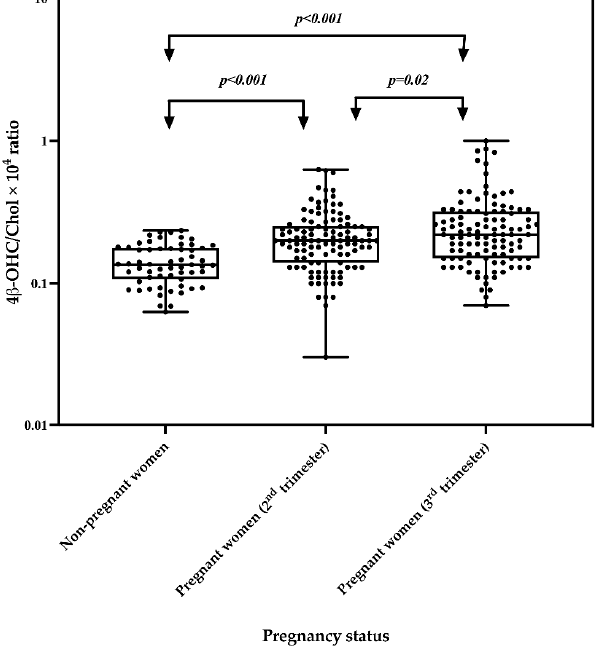
Figure 1. Comparison of the geometric mean of the 4 β -OHC/Chol × 10 4 ratio between non-pregnant and pregnant women in the second and third trimesters. The box plots show the mean ± SD, while whiskers denote the minimum and maximum values.